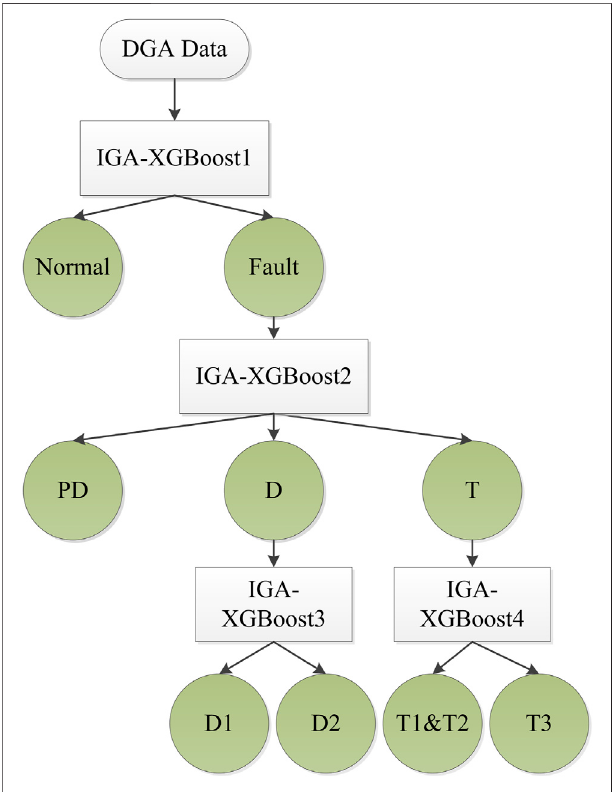
FIGURE4| Structureofthetransformerfaultdiagnosissystembasedon the IGA-XGBoost. Transformer states are classi fi ed into six categories, and four IGA-XGBoost classi fi ers are used to diagnose the fault type step by step in the transformer fault diagnosis system.